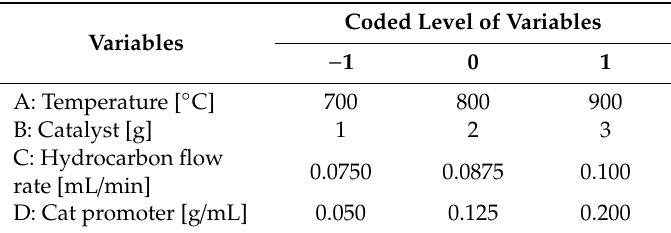
Table 1. Response surface methodology (RSM) experimental factors and levels.